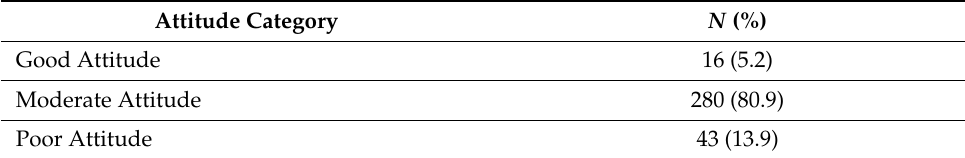
Table 7. Descriptive statistics of the attitude categories.